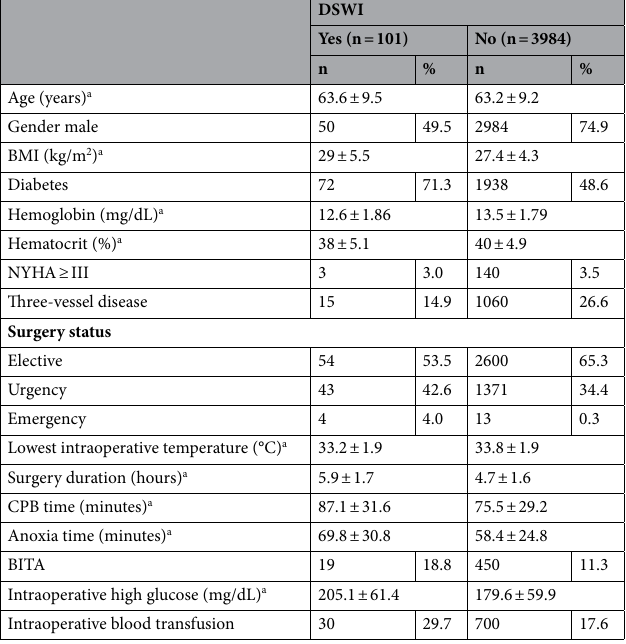
Table 1. Baseline characteristics of patients undergoing isolated CABG surgery with and without DSWI (n = 4085). REPLICCAR II, São Paulo, Brazil, 2017–2019. BMI: body mass index; MI: myocardial infarction; NYHA: New York Heart Association; CPB: cardiopulmonary bypass; BITA: bilateral internal thoracic artery. a Mean ±